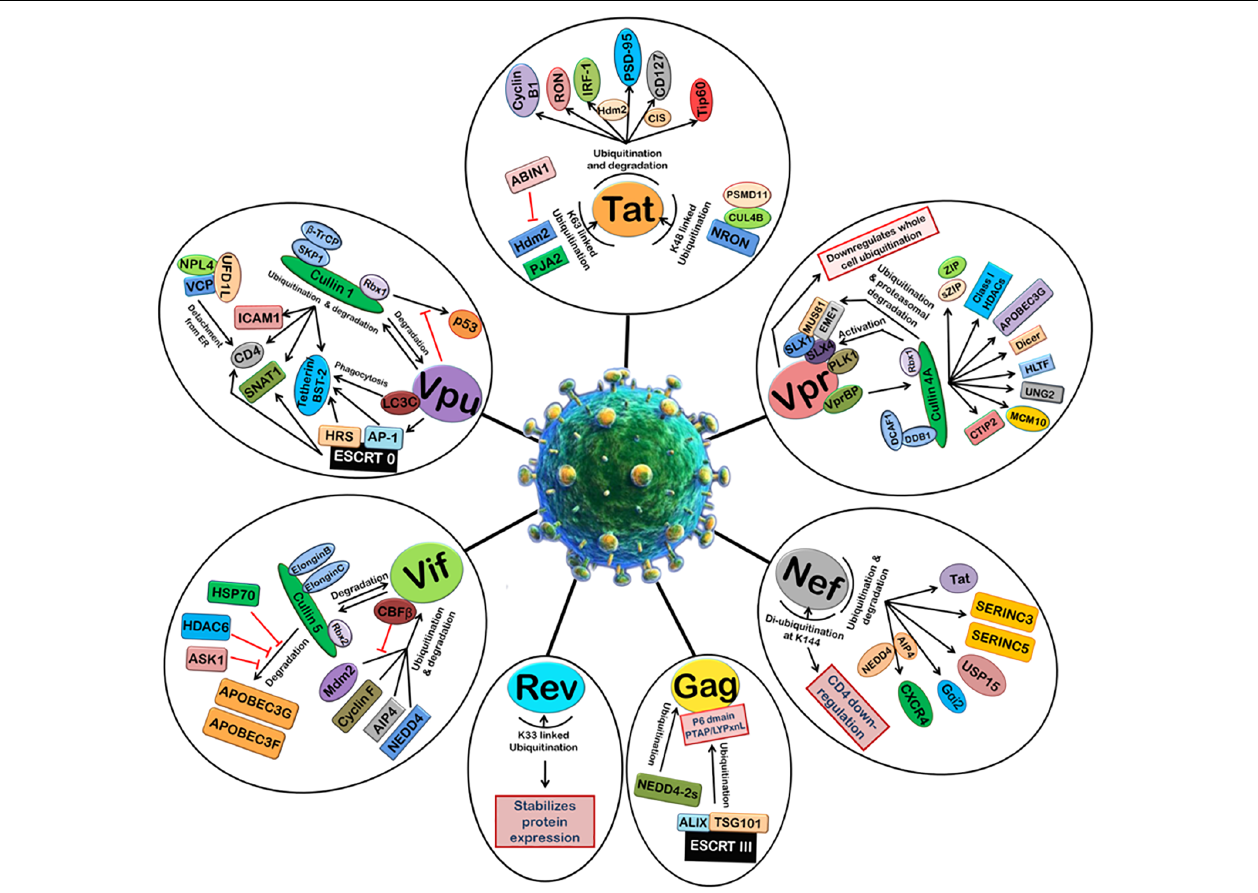
FIGURE 2 | Manipulation of host 26S proteasomal machinery by HIV-1 proteins. HIV-1 proteins redirect the host cellular 26S proteasomal machinery in order to counteract host restriction factors and promote viral replication. Tat induces the ubiquitination and degradation of Cyclin B1, RON, IRF-1 (Hdm2 E3 ligase), PSD-95 (Hdm2 E3 ligase), CD127 (CIS E3 ligase), and Tip60. Tat also undergoes K48-linked polyubiquitination by NRON-CUL4B-PSMD11 complex and K63-linked ubiquitination by Hdm2 and PJA2. ABIN1 inhibits Hdm2-mediated K63-linked ubiquitination of Tat. Vpr can downregulate whole cell ubiquitination and redirect it to degradation of selected host proteins. Vpr binds VprBP-Cullin4A-DCAF-1-DDB-1-Rbx1 E3 ligase complex and causes ubiquitin-dependent degradation of CTIP2, MCM10, UNG2, HLTF, Dicer, APOBEC3G, Class I HDACS, ZIP, sZIP, MUS81, and EME1. Nef induces ubiquitination and degradation of Tat, SERINC3, SERINC5, USP15, G α i2 (AIP4 E3 ligase), and CXCR4 (AIP4 and NEDD4 E3 ligases). Nef is de-ubiquitinated itself at K144 and causes CD4 downregulation. HIV-1 Gag is also ubiquitinated by ESCRT III machinery and NEDD4-2s which is required for the assembly and release of new viral particles. K33-linked ubiquitination of Rev stabilizes its expression. Vif binds Cullin5-ElonginB-ElonginC-Rbx2 E3 ligase complex to ubiquitinate and degrades APOBEC3G and APOBEC3F. This is inhibited by HSP70, HDAC6, and ASK1. Vif is itself ubiquitinated and degraded by Cullin5-ElonginB-ElonginC-Rbx2 E3 ligase complex and also other E3 ligases such as Mdm2, Cyclin F, AIP4, and NEDD4. CBF β inhibits Mdm2-mediated ubiquitination of Vif. Vpu induces degradation of ICAM1, CD4, SNAT1, and Tetherin/BST-2 with the help of Cullin1- β TrCP-SKP1-Rbx1 E3 ligase complex and ESCRT 0 complex. Vpu is also ubiquitinated by Cullin1- β TrCP-SKP1-Rbx1 E3 ligase complex. The degradation of p53 by Cullin1- β TrCP-SKP1-Rbx1 E3 ligase complex is also inhibited by